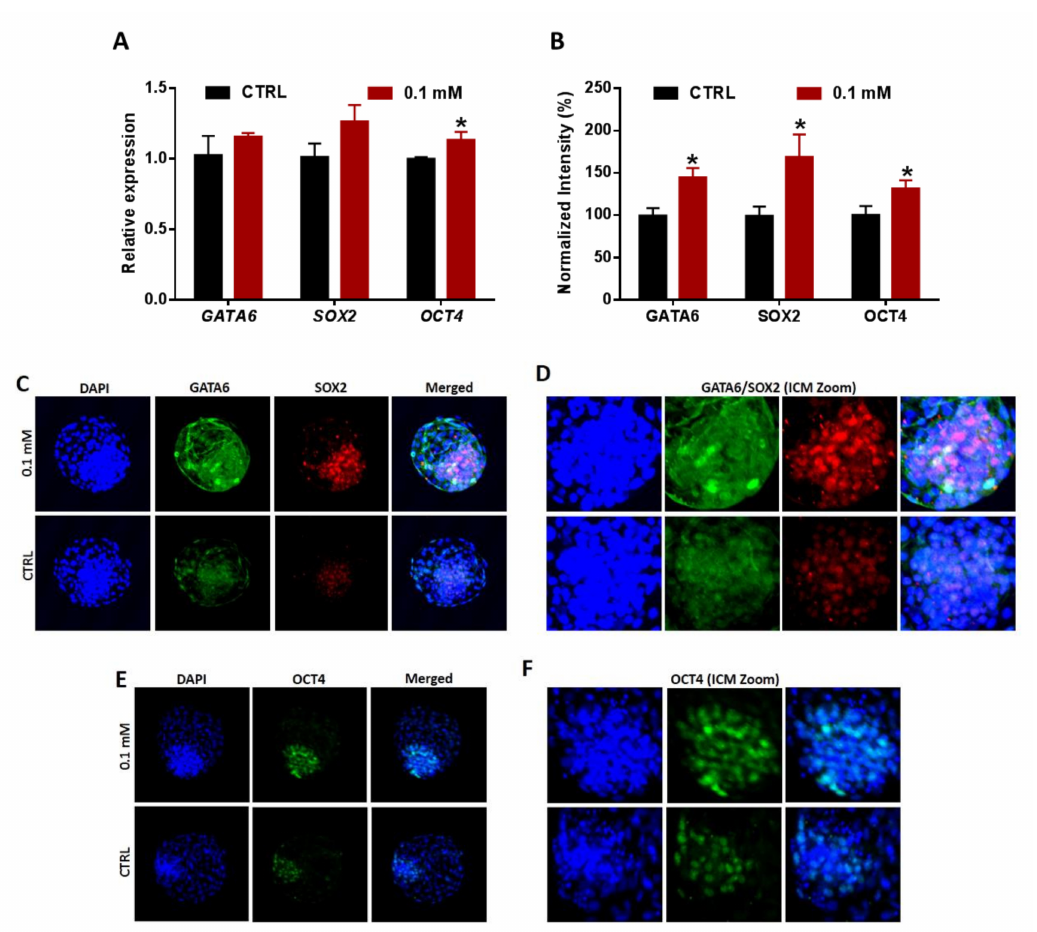
Figure 8. Transcriptional and translational levels of various factors related to ICM pluripotency in day-8 embryos. ( A ) The mRNA levels of GATA6 , SOX2 , and OCT4 in treated and control embryos. ( B ) Integrated optical density of GATA6, SOX2, and OCT4. ( C ) Laser scanning confocal microscopy of GATA6 and SOX2. ( D ) GATA6 and SOX2 signal zoom showing localization in the ICM. ( E ) Immunofluorescence of OCT4 in day-8 blastocyst. ( F ) Zoom of OCT4 signal localized in the ICM cells. Original magnification 100 × . The asterisk indicates statistical